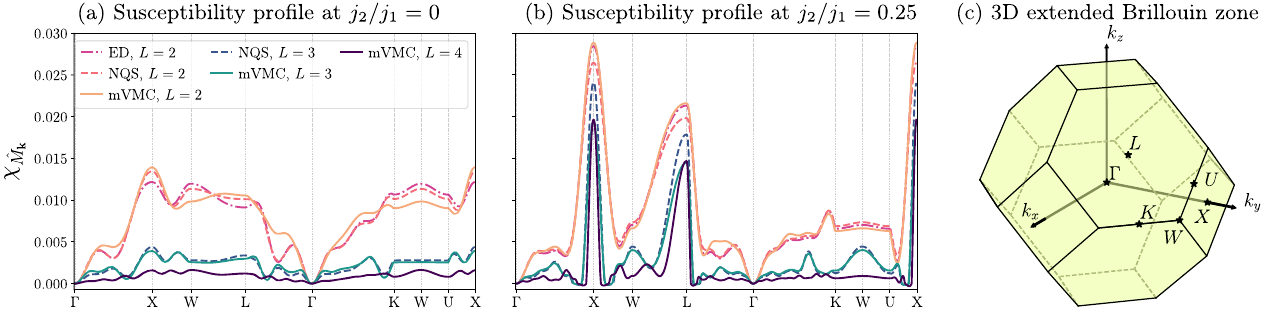
FIG. 3. Spin-spin susceptibility χ ˆ M evaluated for the SU ð 2 Þ -symmetric model ( λ ¼ 1 ) for (a) the frustrated phase with j 2 =j 1 ¼ 0 and k (b) the k ¼ 0 magnetic phase with j 2 =j 1 ¼ 0 . 25 . The legend shows the methods and the size of the equilateral clusters used. (c) Extended Brillouin zone of the pyrochlore lattice with the high-symmetry points